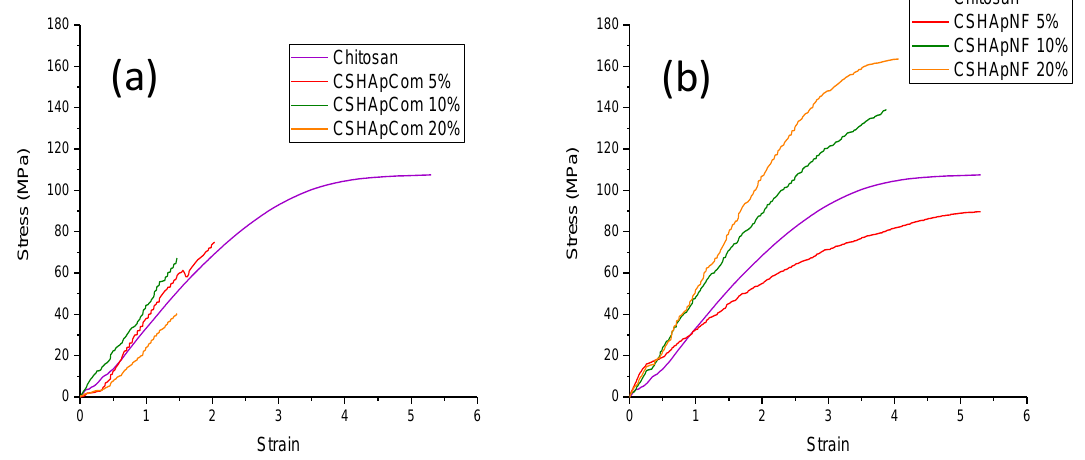
Figure 10. Stress–strain curves for ( a ) reference materials and ( b ) HAp nanofibers/chitosan composite materials. Notice the differences in mechanical resistance under tension.